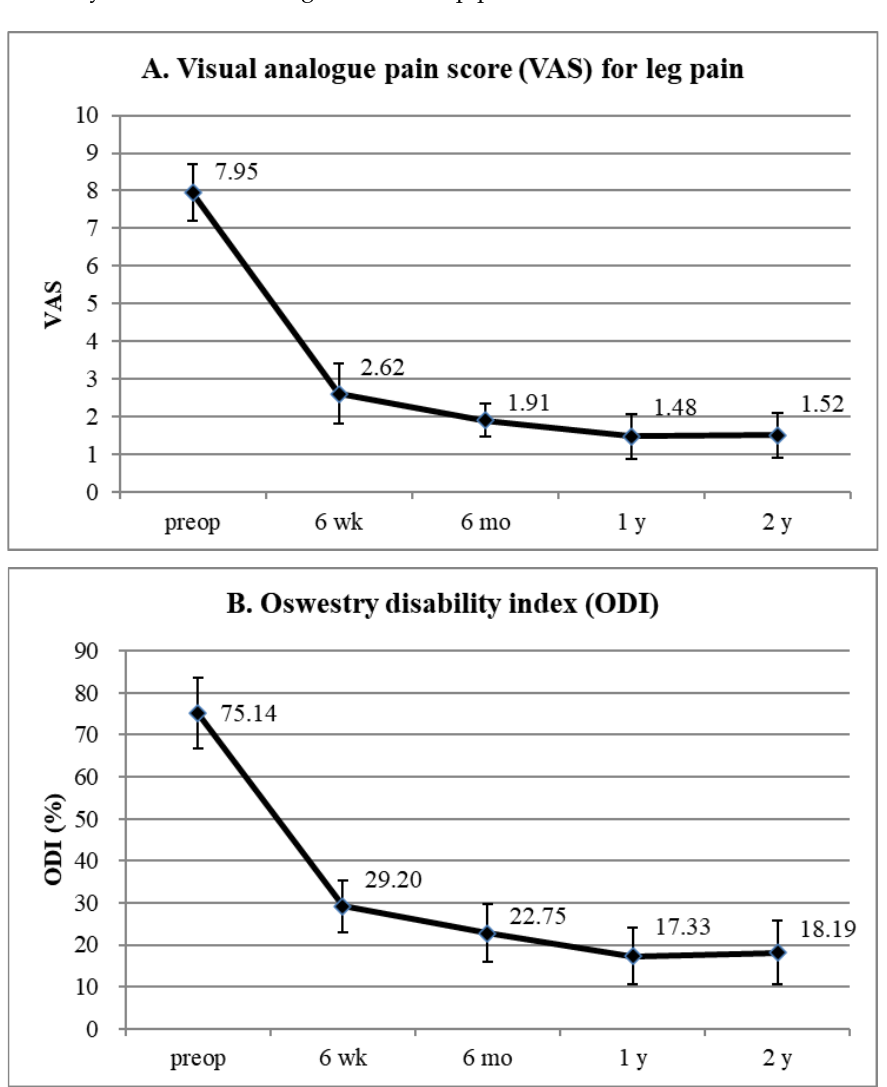
Figure 5. Clinical results. ( A ) Visual analog pain scale for radicular pain preoperatively and at 6 weeks, 6 months, 1 year, and 2 years postoperatively. ( B ) Oswestry disability index scores preoperatively and at 6 weeks, 6 months, 1 year, and 2 years postoperatively.